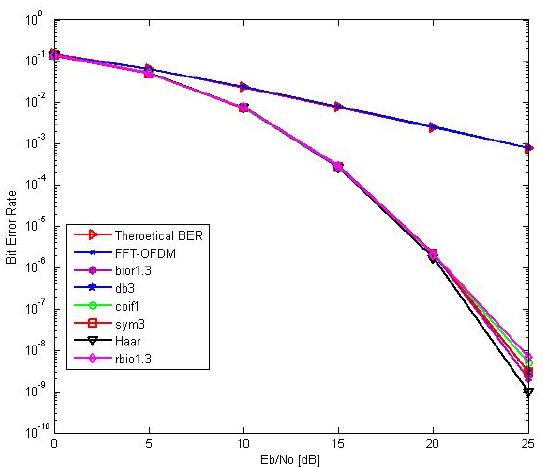
Figure 7. BER performance comparisons of the DWT-OFDM and the FFT-OFDM systems over Rayleigh channel model using several wavelets.